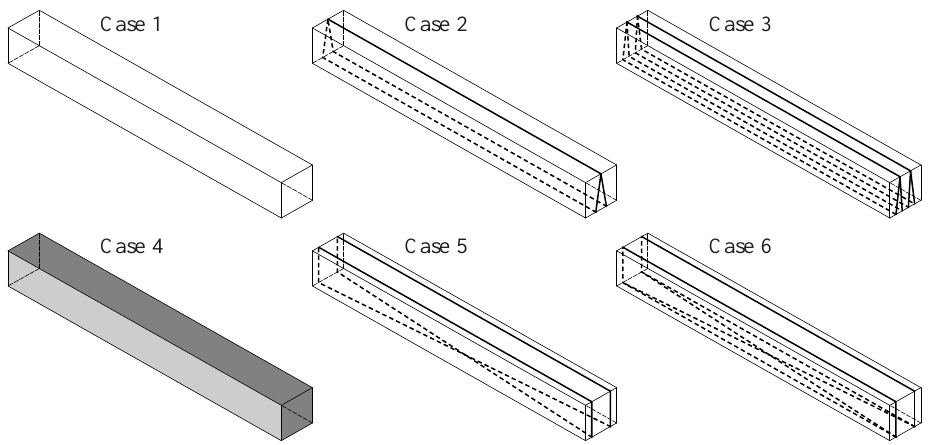
Figure 1. Different reinforcement mechanisms (Cases 2, 3, 4, 5, 6) compared to the benchmark/unreinforced case (Case 1).